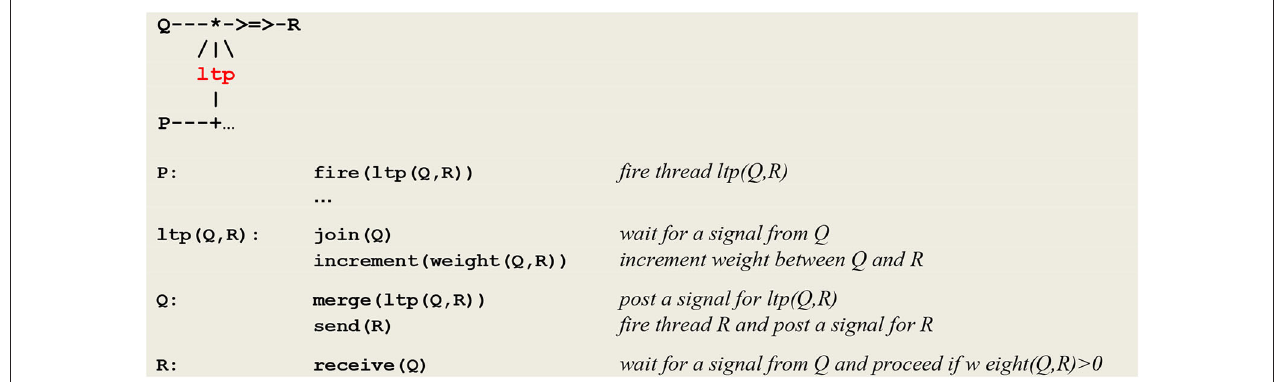
FIGURE 6 | Micro-circuit and communication protocol for ltp. In order to detect the coincidence of P and Q , thread P fires an ltp thread that in turn calls on a join procedure to wait for a signal from thread Q . In parallel, thread Q calls on procedure merge to post a signal for ltp and then executes a send ® command to establish a link with thread R . After its synchronization with thread Q , thread ltp increments the weight between Q and R (NB This protocol will be at the heart of the developments to come and will allow for the learning of causality rules).